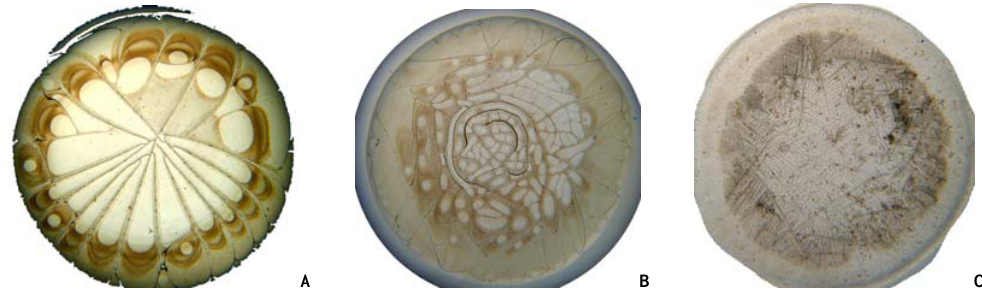
FIGURE 1. Facies: (A) blood serum at norm, (B) blood serum at pathology, (C) saliva at